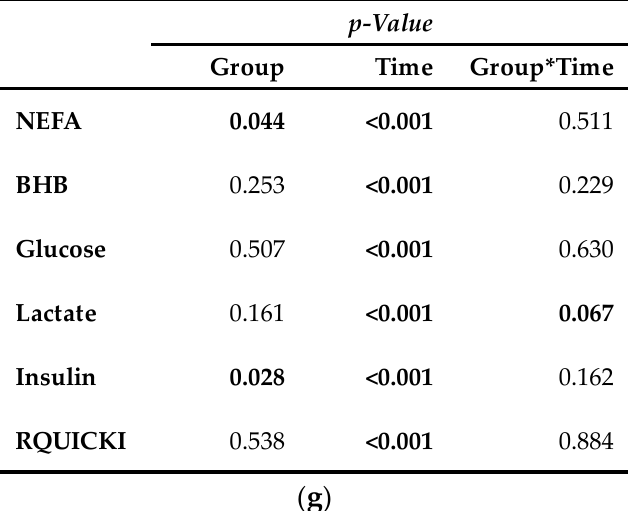
Figure 6. Progression of blood parameters with relevance for energy metabolism of dairy cows fed a non-supplemented (CON) or an L-carnitine supplemented diet (CAR, 25 g/d from 6 weeks ap up to day 126 pp) before and after an intravenous injection of 0.5 µ g/kg BW lipopolysaccharides (LPS) on day 111 pp (red arrow). ( a ) Concentration of non-esterified fatty acids (NEFA) and ( b ) β -hydroxybutyrate (BHB) in serum, ( c ) glucose and ( d ) lactate in whole blood, ( e ) insulin in serum and ( f ) Revised Quantitative Insulin Sensitivity Check Index (RQUICKI) = 1 ( g ) Data statistics. Data are given as LS-Means standard errors. Significant p -Values are marked as bold.